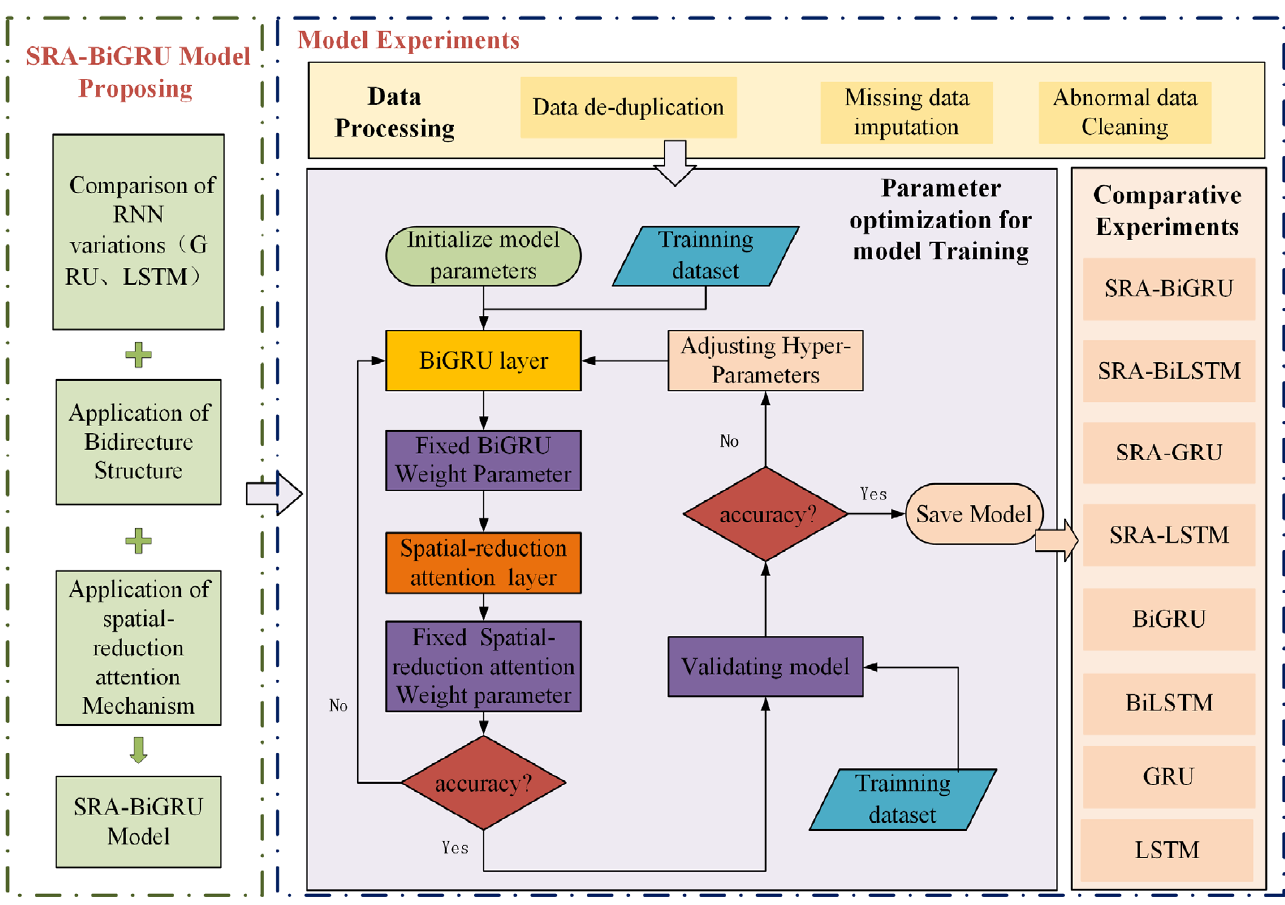
Figure 1. Flowchart of the water-level-prediction method.